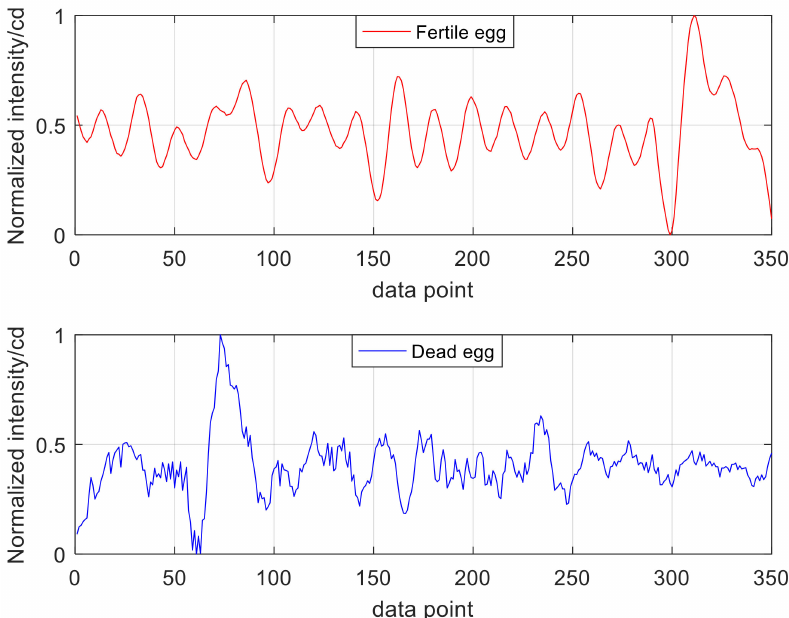
Figure 3. The filtered waveform of a collected heartbeat signal of a hatching egg. Only 350 sampling points out of a total 500 are used due to the first 150 data points being unstable after filtering.